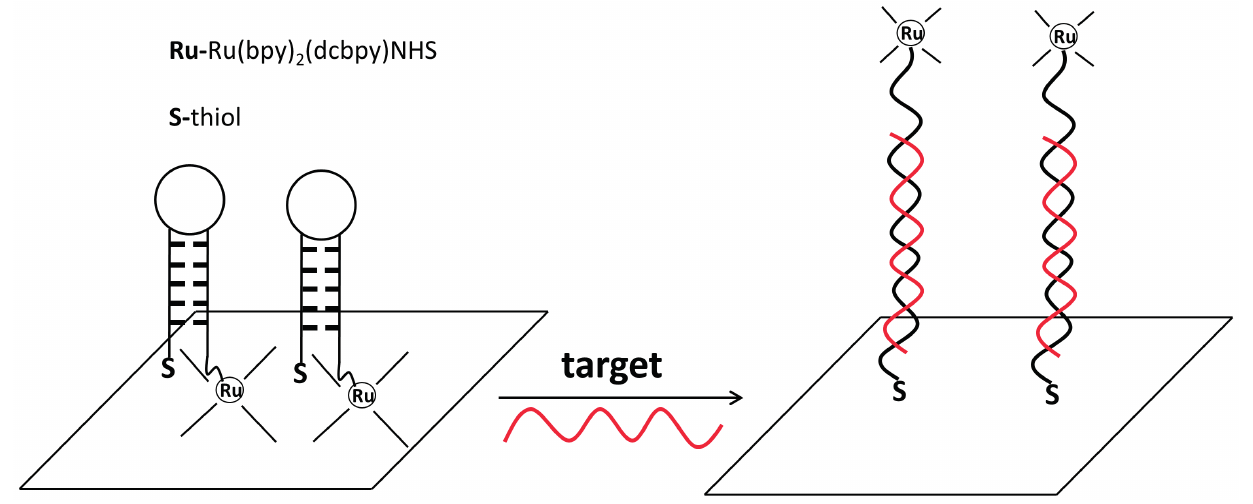
Figure 12. Schematic of a hairpin-DNA probe for DNA detection. Reprinted with permission from ref. [177], copyright (2008) American Chemical